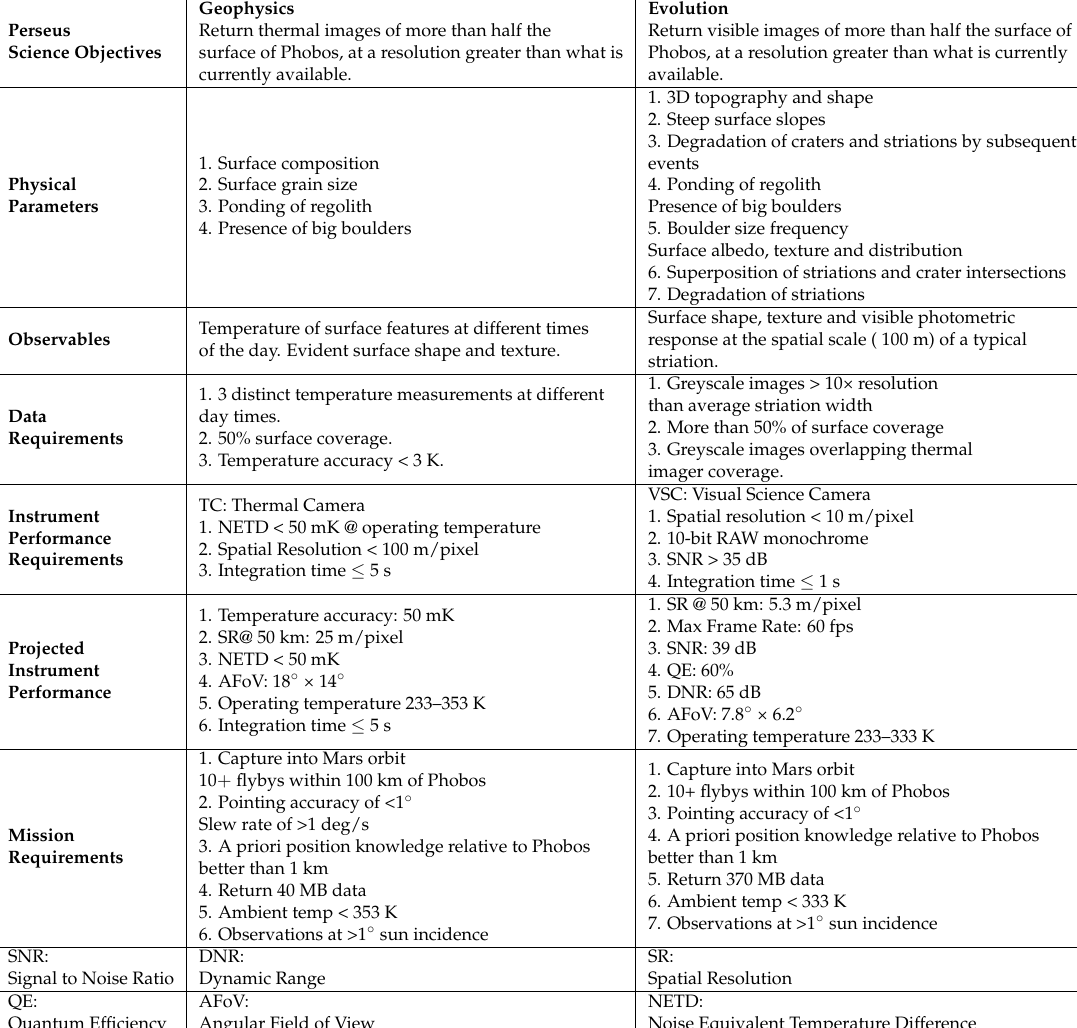
Table 1. Science traceability matrix for the Perseus mission